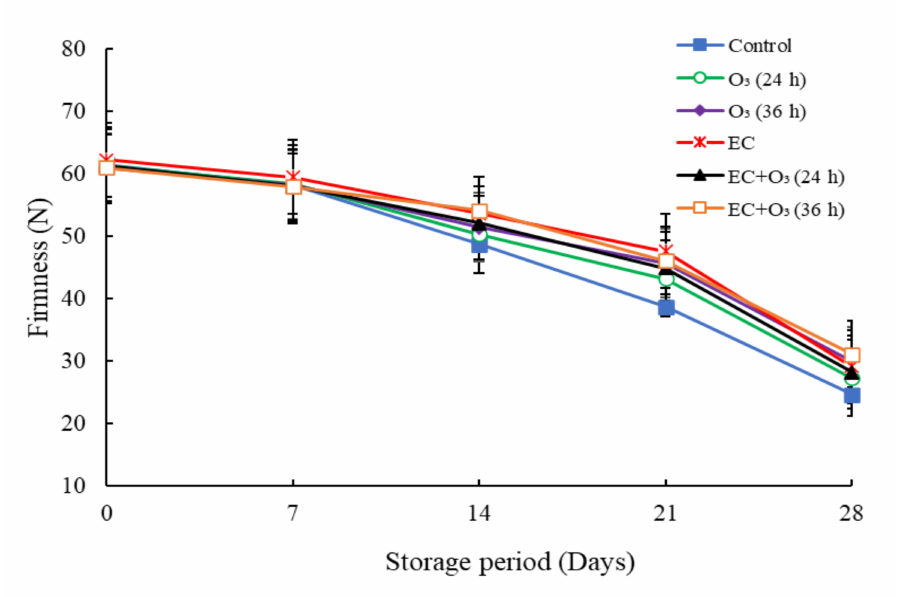
Figure 1. Effect of edible coating (EC) and gaseous ozone (O 3 ) on mango fruit firmness stored at 10 ◦ C for twenty-one days and seven days shelf-life at ambient temperature ( ± SE, n =